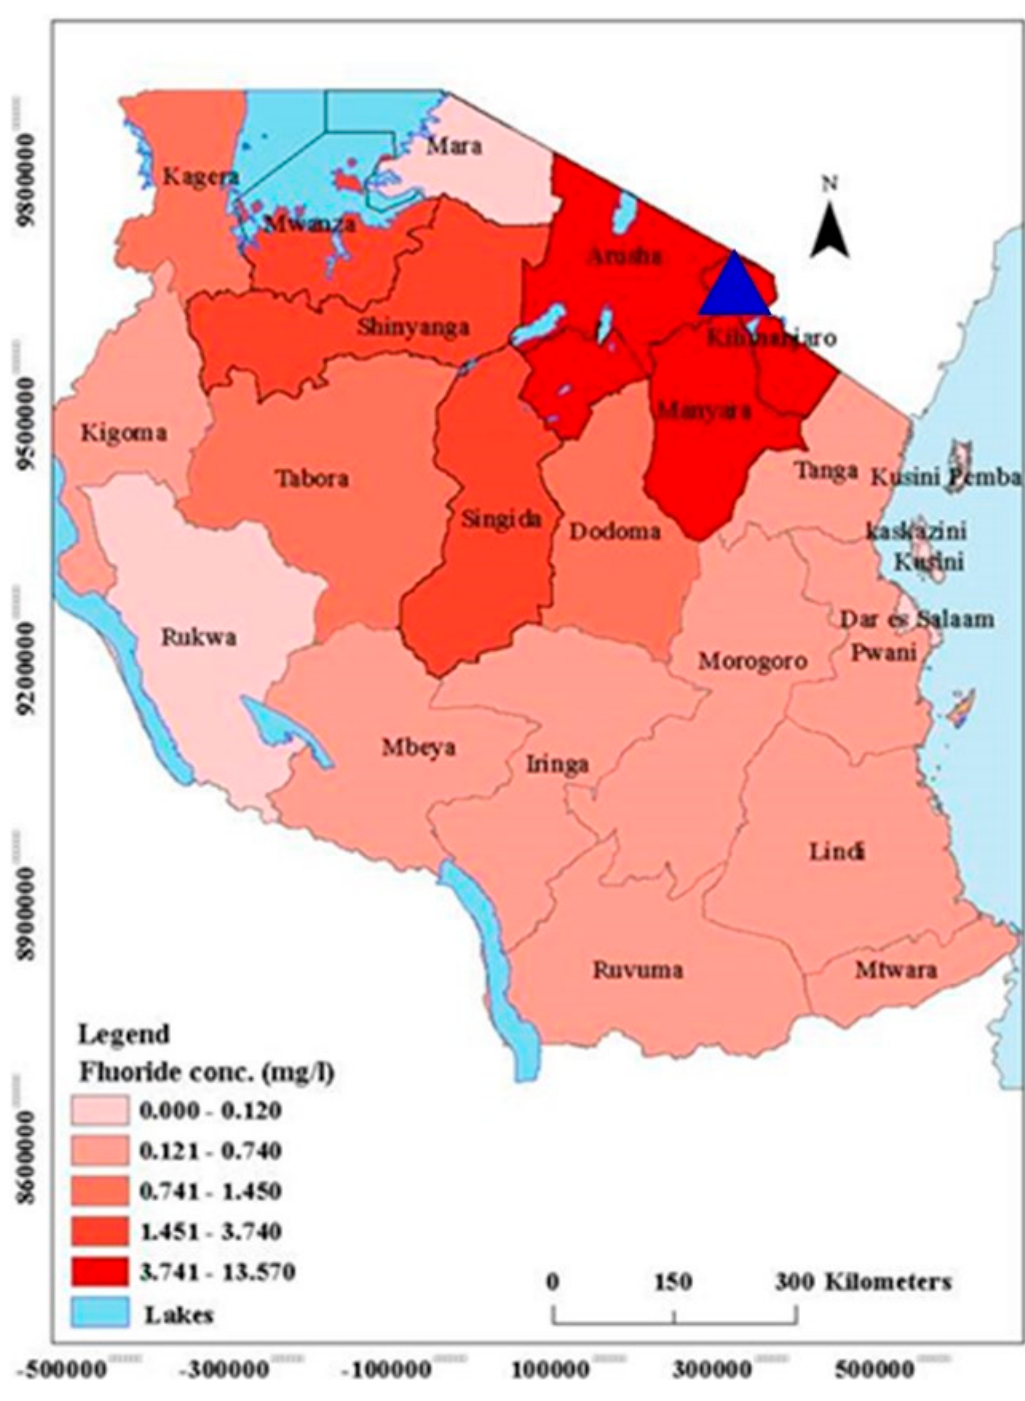
Figure 1. A map of Tanzania showing fluoride distribution by regions (from ref. [45]). The blue triangle ( (cid:78) ) indicates the location of Kilimanjaro Mountains.